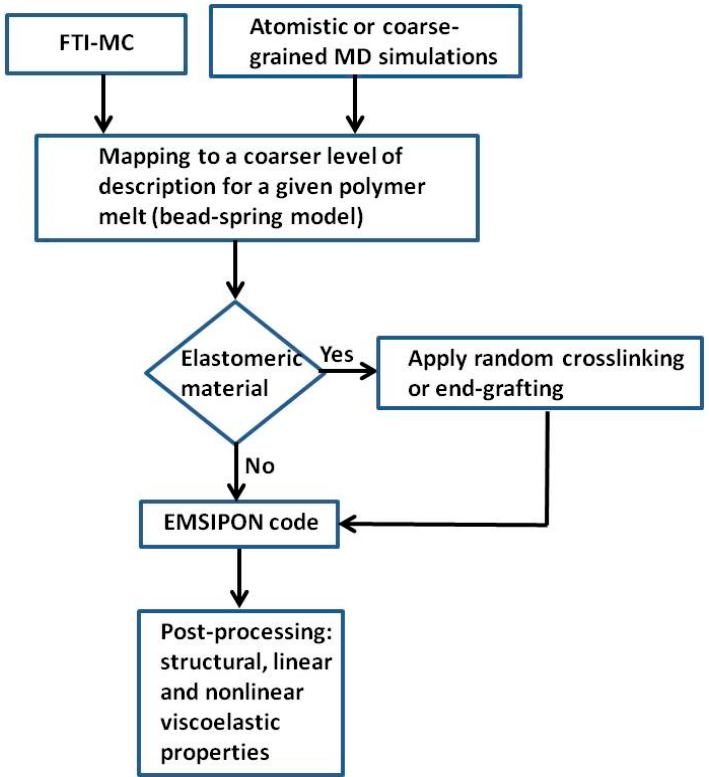
Scheme 1. Flow diagram for the presented multiscale